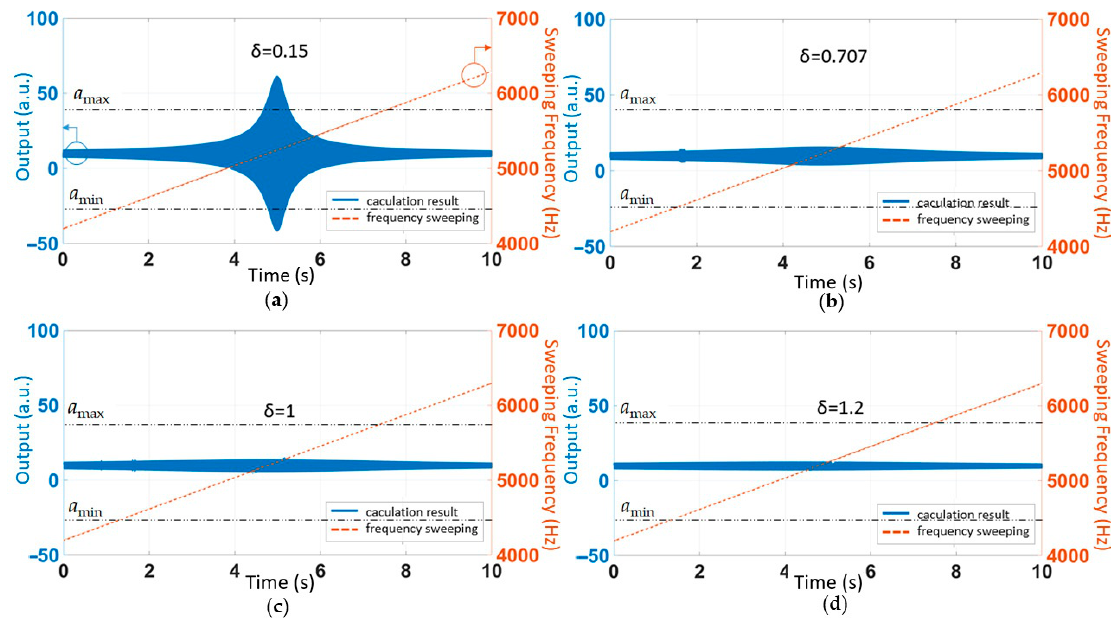
Figure 13. The accelerometer’s output in the case of different damping ratios. ( a ) δ = 0.15, underdamped system. ( b ) δ = 0.707, underdamped system. ( c ) δ = 1, critically damped system. ( d ) δ = 1.2, overdamped system.